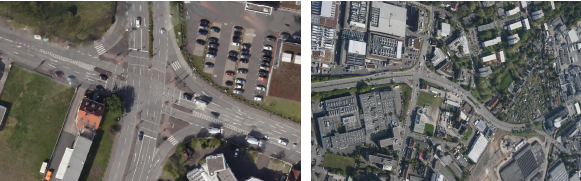
Figure 2. Crossing “Am Seedamm/Eschborner Landstraße” in Frankfurt am Main (Germany), left: aerial ortho image 150 × 90 m 2 , GSD 15 cm, right: original right looking image containing the crossing (south is right) Also very high resolution (VHR) satellite images (e.g.